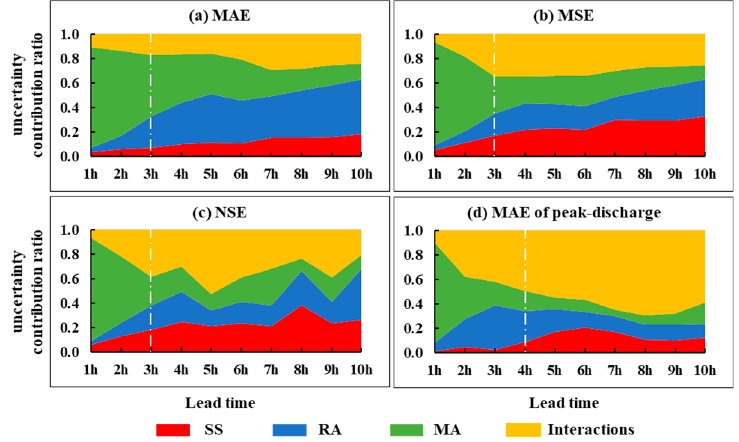
Figure 16. The ratio of the contributions of uncertainty sources at 1–10 ‐ h lead ‐ time.